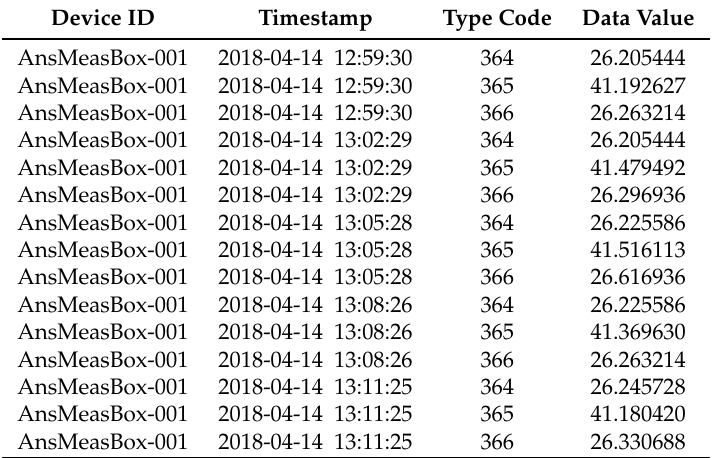
Table 1. Extract from a MIMOSA record: Temperature (364,366) and humidity (365) data are shown